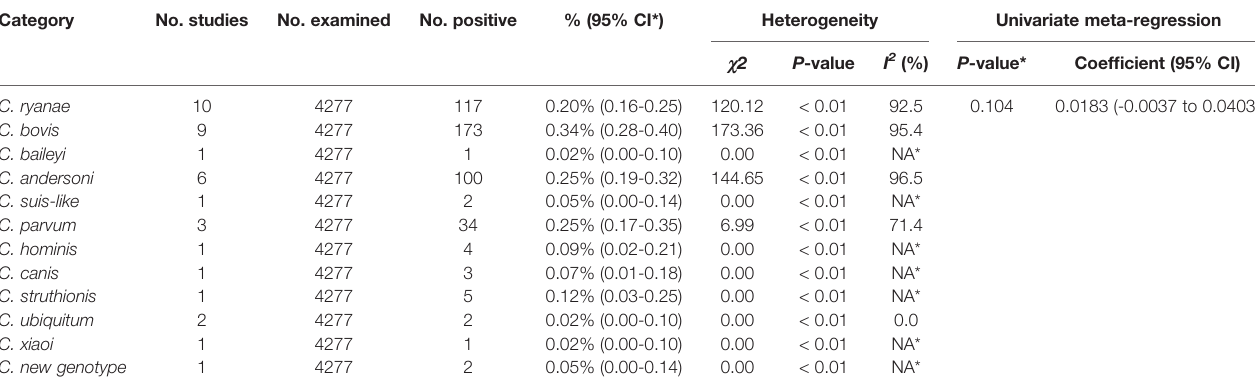
TABLE 4 | The species/genotype of Cryptosporidium in yaks was detected by